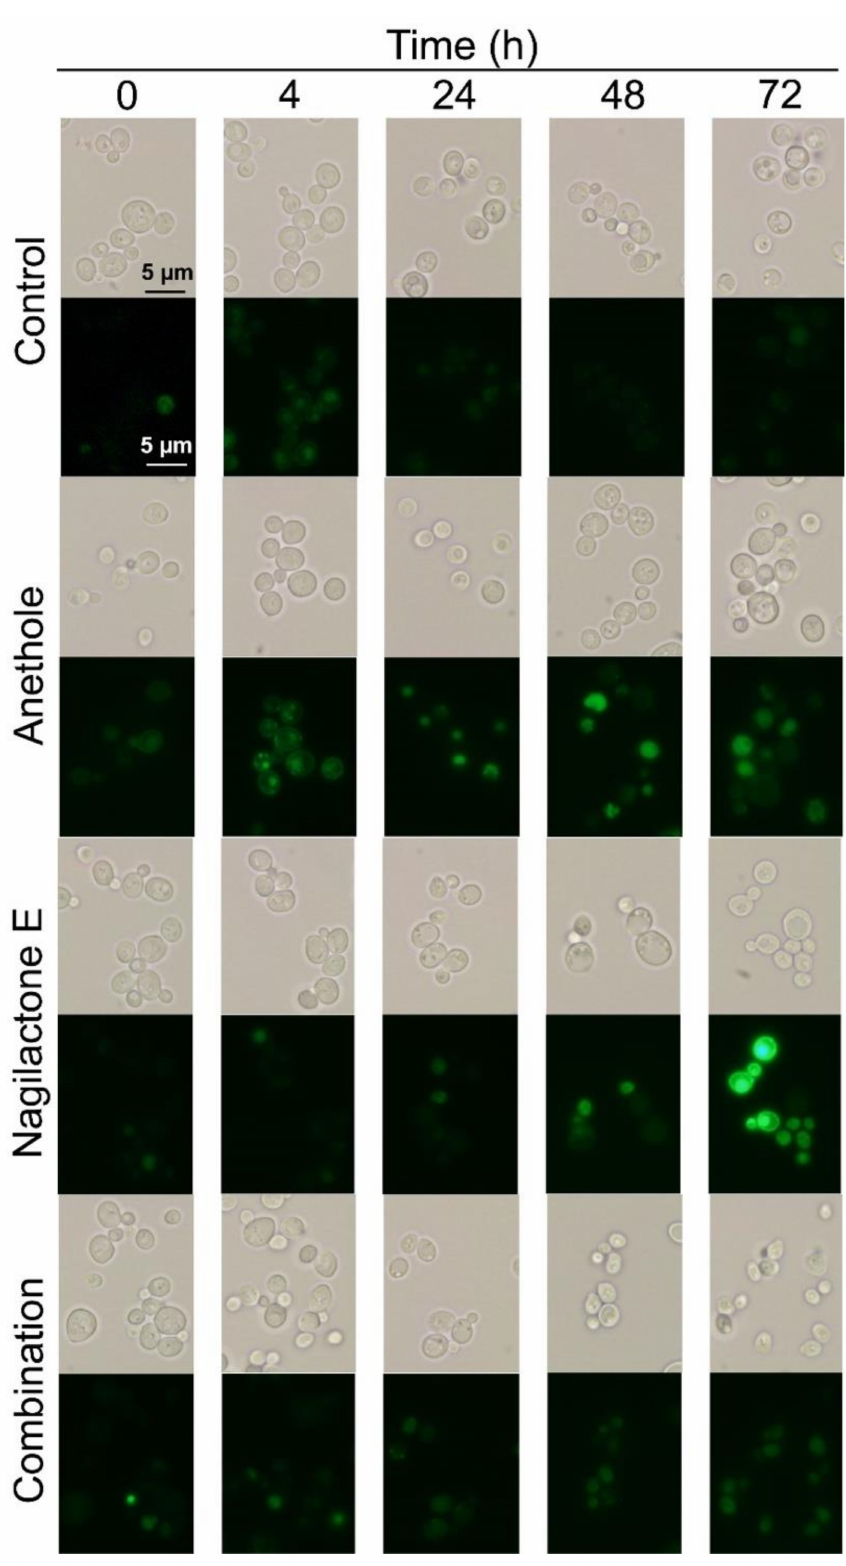
Figure 5. Phase-contrast and fluorescent micrographs of cells expressing Pdr5p tagged with green fluorescent protein. Exponentially growing cells were grown at 30 ◦ C in 2.5% ME treated with 312.5 µ M anethole, 250 µ M nagilactone E, or their combination. Control denotes treatment without drugs. Refer to Supplementary Figure S1 for the original uncropped photos of cells after 72 h of incubation with and without